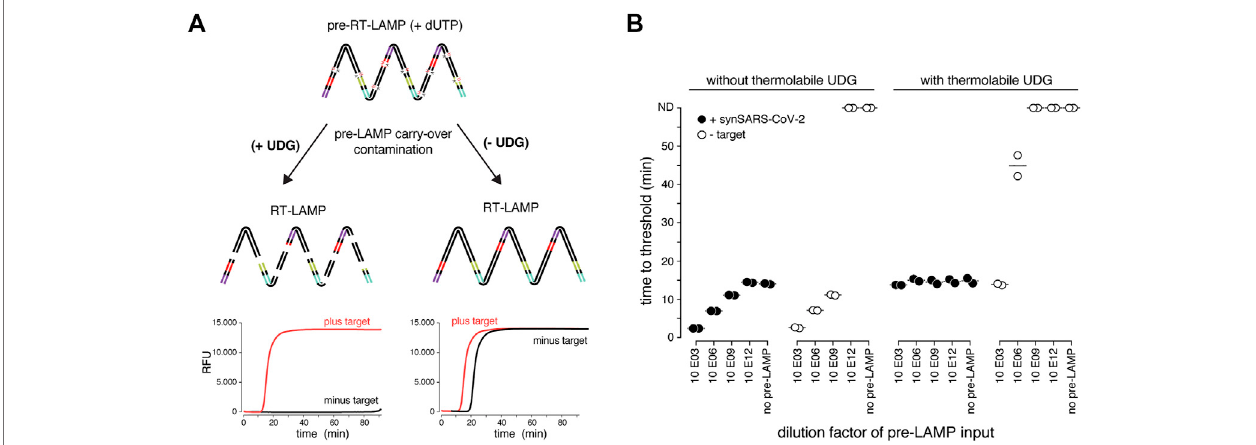
FIGURE 2 | The dUTP/UDG system prevents carry-over cross-contamination in RT-LAMP. (A) Schematic depicting the principle of the dUTP/UDG system in preventingcarry-overcontamination.dUTPisincorporatedintoLAMPampliconsinaprimaryreaction(pre-RT-LAMP).dUTPcontainingLAMPproductscarriedoverinto a subsequent reaction (RT-LAMP) are cleaved by UDG prior to LAMP-based ampli fi cation, making them unavailable as ampli fi cation templates. This allows robust discrimination between target and no-target control (left), which is challenged by cross-over contamination in the absence of UDG-mediated cleavage (right). (B) The dUTP/UDG system minimizes cross-over contamination. Shown are performances (time to threshold) ofRT-LAMP reactions in the absence (left) or presence (right) of thermolabile UDG when using synthetic SARS-CoV-2 ( fi lled circles) or water (open circles) as input. Reactions were supplemented with the indicated dilution of a dUTP-containing pre-LAMP reaction. All reactions were performed in